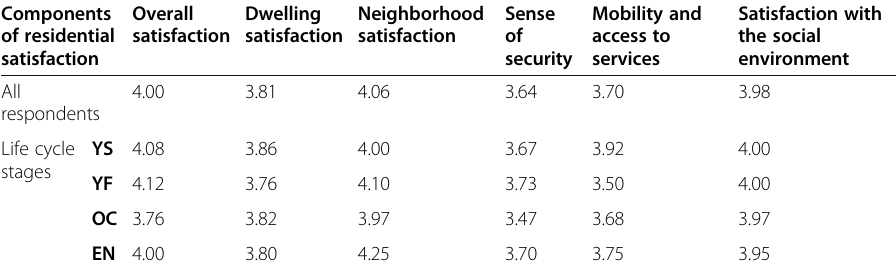
Table 4 Ratings of overall residential satisfaction and of the components of residential satisfaction (means) Components of